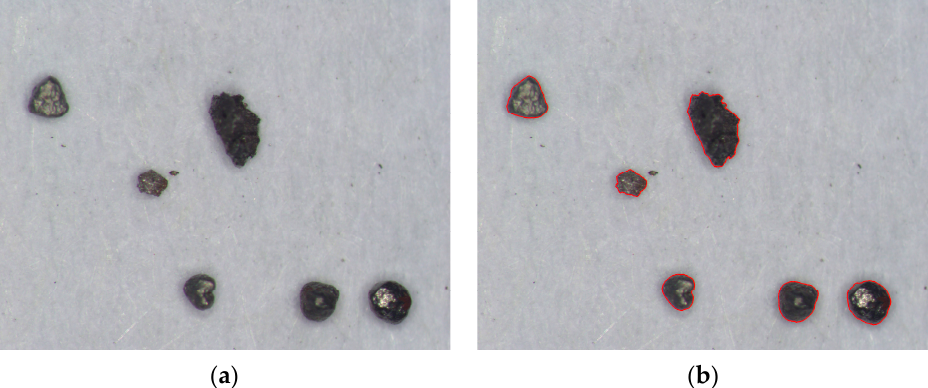
Figure 10. Oil-particle contour-extraction result: ( a ) Origin image; ( b ) Particle contours.